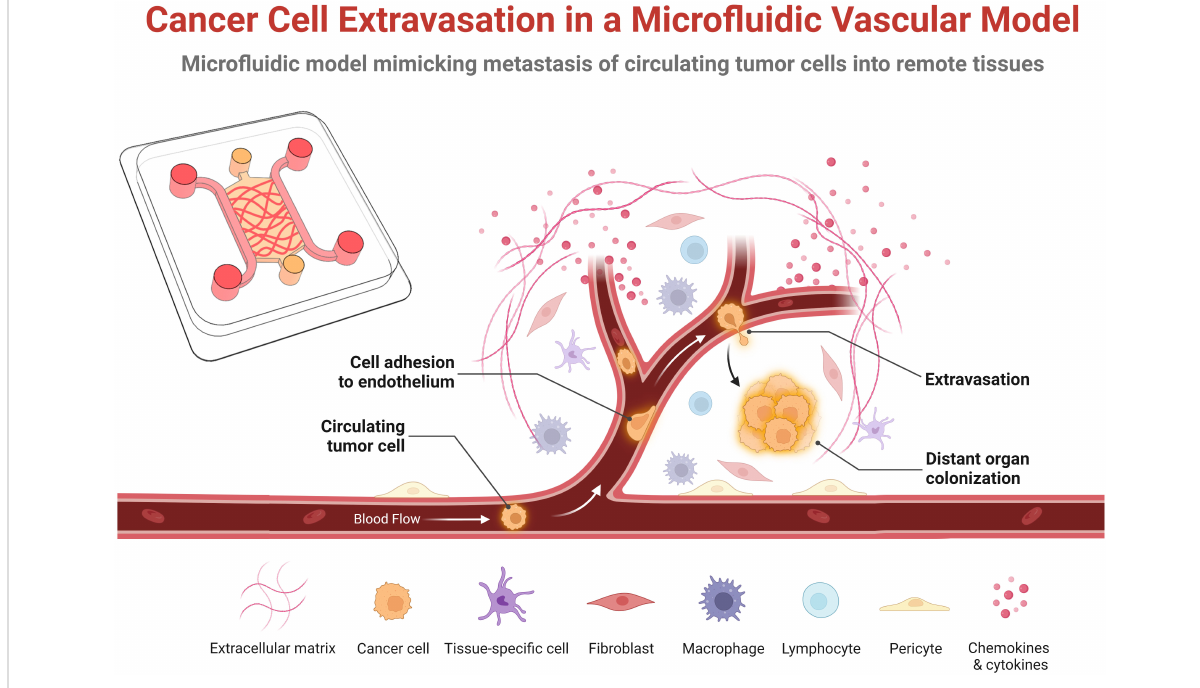
FIGURE 1 Schematic representation of the key steps of cancer cell extravasation within a micro fl uidic vascular model. Circulating tumor cells originate from the primary tumor, enter the bloodstream that transports them to a distance organ or tissue where they adhere or become physically trapped in the microvasculature. Some fraction of these survive in the vessel and undergo trans-endothelial migration by extending protrusions across the endothelial monolayer, adhering to the basal membrane and extracellular matrix, and pulling or pushing itself across the endothelial monolayer into the underlying tissue. In the extravascular space, the extravasated tumor cells then either proliferate, die, or enters into a dormant state. This schematic was created with